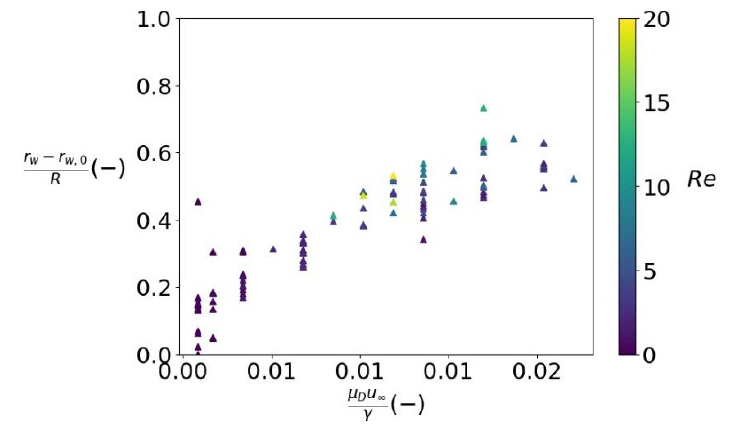
Figure 14. Averaged wetting radius of water droplet on a wire mesh screen.